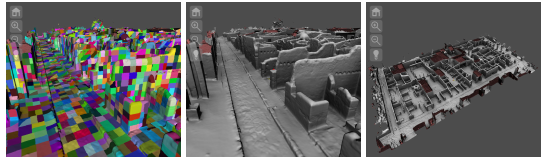
Figure 1: The multiresoluton Engine. On left: the patches used , smaller and more detailed near the camera, larger and at a lower- resolution farther away. Middle: when rendering, the geometry appear as a continous surface. On right: the multiresolution eas- ily manage the whole 27 million triangles model of the Pompeii Insula.